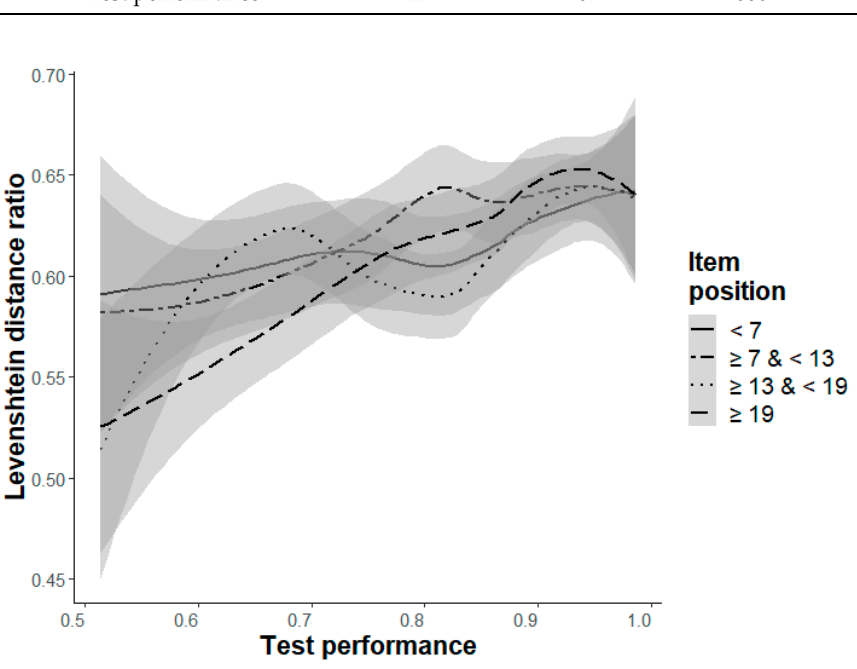
Figure 5. Interaction effect of item position (grouped in four intervals, indicated by four lines) with .95-confidence-interval and test performance (ACC-poss, x-axis) on the Levenshtein distance ratio for Level d.